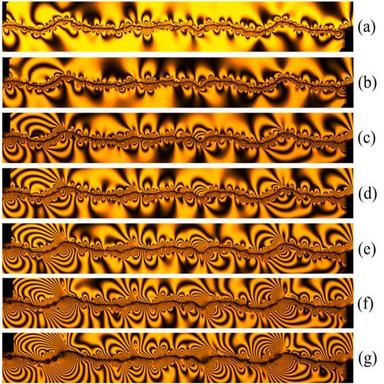
Evolution of plastic shear zones at different shear displacements of (a) 0.3 mm, (b) 0.6 mm, (c) 0.9 mm, (d) 1.2 mm, (e) 1.5 mm, (f) 1.8 mm, and (g) 2.1 mm . The copyright permission for this figure has been granted.